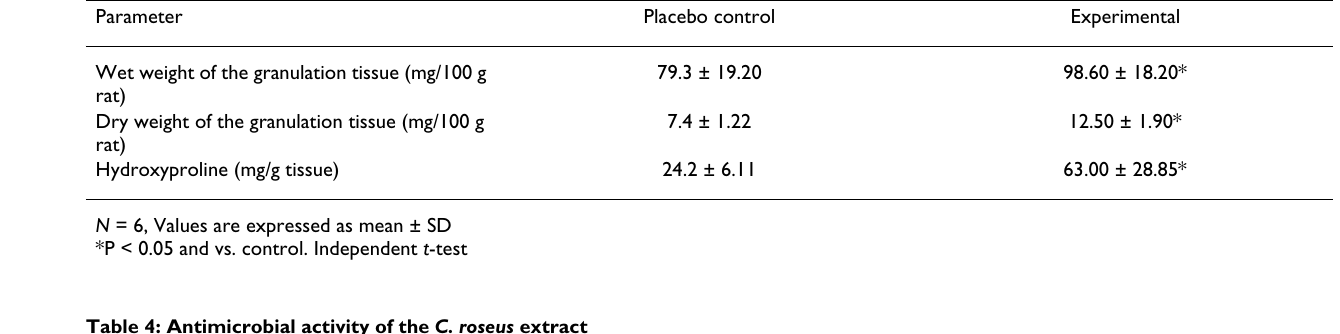
Table 4: Antimicrobial activity of the C. roseus extract Bacteria Pseudomonas aeruginosa , +++ Beta-hemolytic streptococci